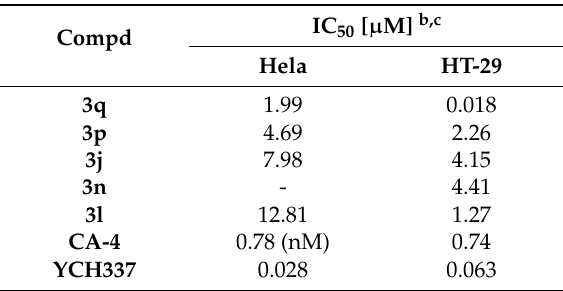
Table 3. Anti-proliferation activity of selected compounds